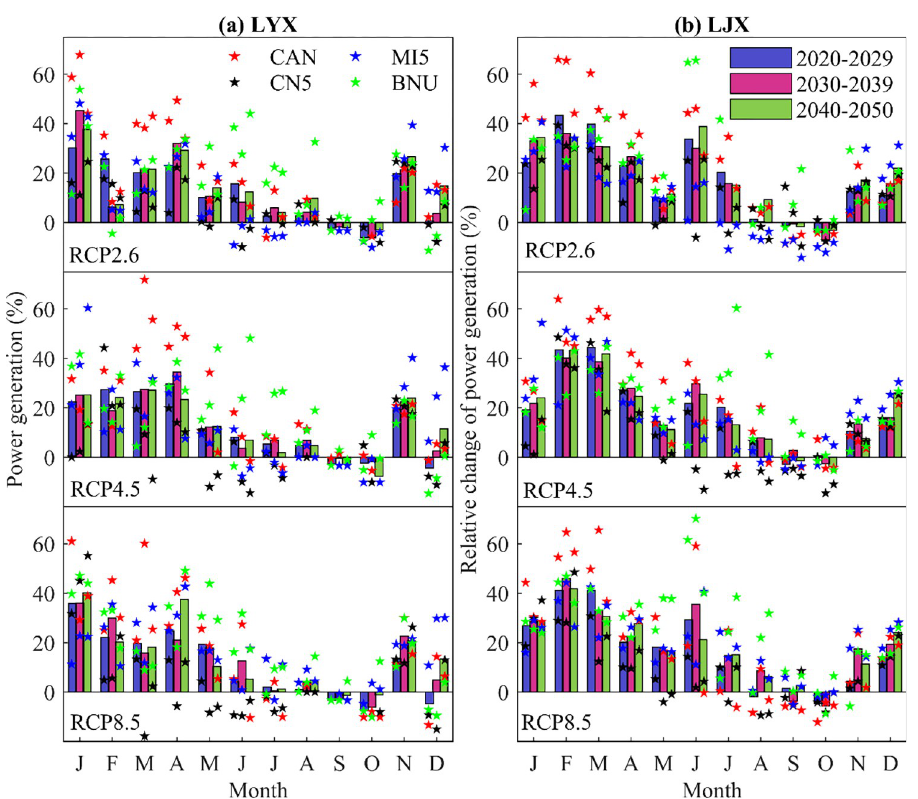
Fig 10. Inner-annual power generation of LYX and LJX reservoirs under different climate